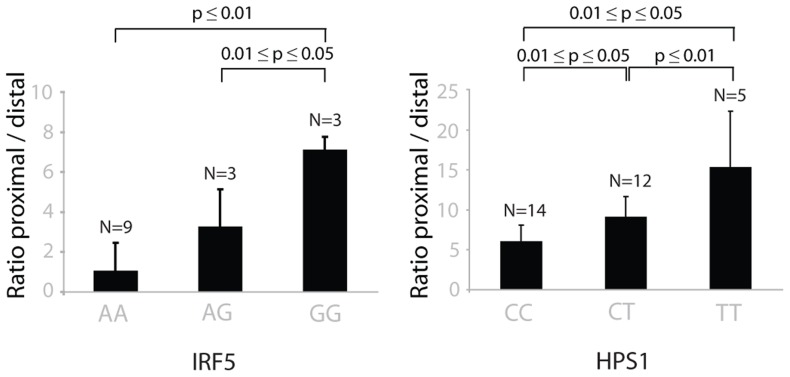
The choice of proximal/distal polyadenylation site in genes IRF5 and HPS1 depends on the genotypes of rs10488630 and rs11189600, respectively.The ratio between the abundance of transcripts with proximal and distal 3′-UTR RT-qPCR products in IRF5 (left) and HPS1 (right) depends on the genotypes of cis-regulating SNPs rs10488630 and rs11189600, respectively. N denotes the number of individuals included in the analysis. These results indicate allele-specific preference for use of a proximal and distal polyadenlyation site.